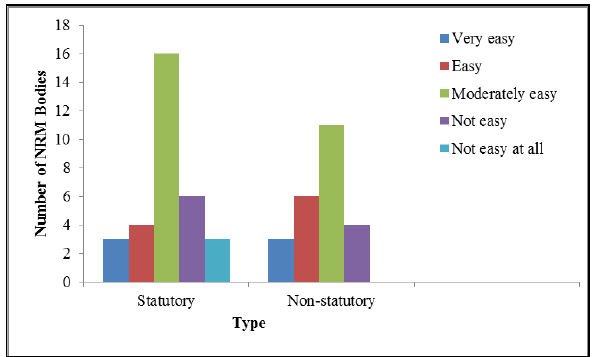
Figure 3. Ease of data access from spatial data